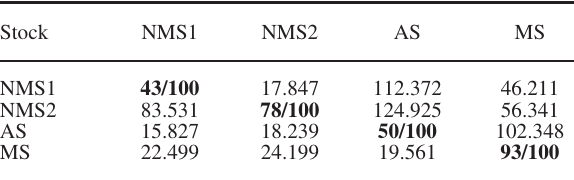
Fig. 4. – Confidence ellipses of DFa scores for morphometric Fig. 5. – Contribution of morphometric characters to the discriminant analysis and uPgma dendrogram based on euclidean distance. mS, functions. Vectors indicate the loadings of the scores for each marmara Sea; aS, aegean Sea; nmS1, north-eastern mediterranean variable on the first two discriminant functions. mW, mantle width; Sea (antalya Bay); nmS2, north-eastern mediterranean Sea nW, neck width; eD, eye diameter; CSD, club sucker diameter; Cl, (iskenderun Bay). club length; DBe, distance between eyes. Table 5. – euclidean distance between stocks of S. officinalis for morphometrics (below diagonal) and cuttlebone chemistry (above diagonal). numbers in the diagonal (bold) are the percentage of individuals classified correctly into their original stock by morphometric / cuttlebone chemistry respectively.